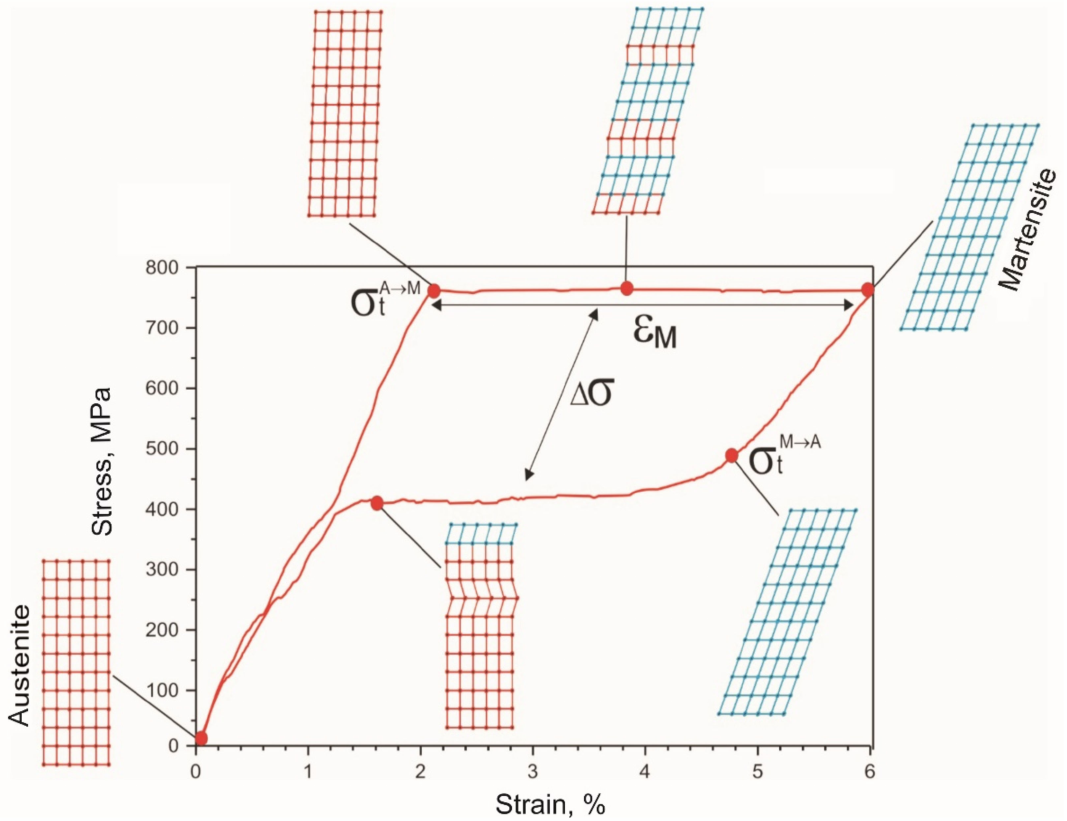
Figure 11. Schematics of twinning in characteristic regions of the NiTi wire uniaxial tension stress-strain